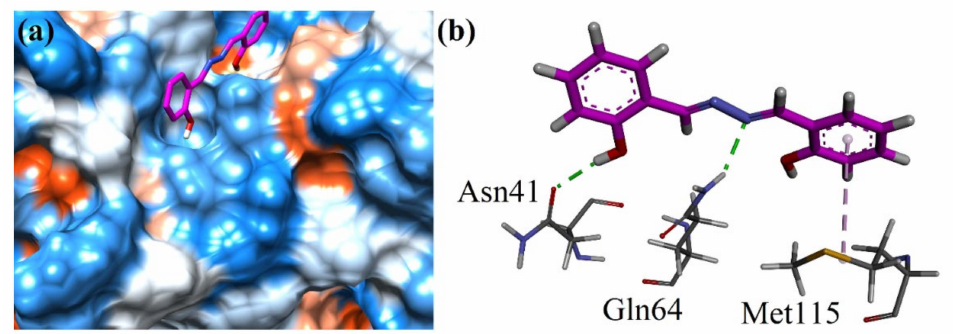
Figure 6. ( a ) The 3D surface diagram of isolated salicylalazine into the binding site of GABA (4COF). ( b ) Close-up 3D interaction plot of purified salicylalazine in the binding site of